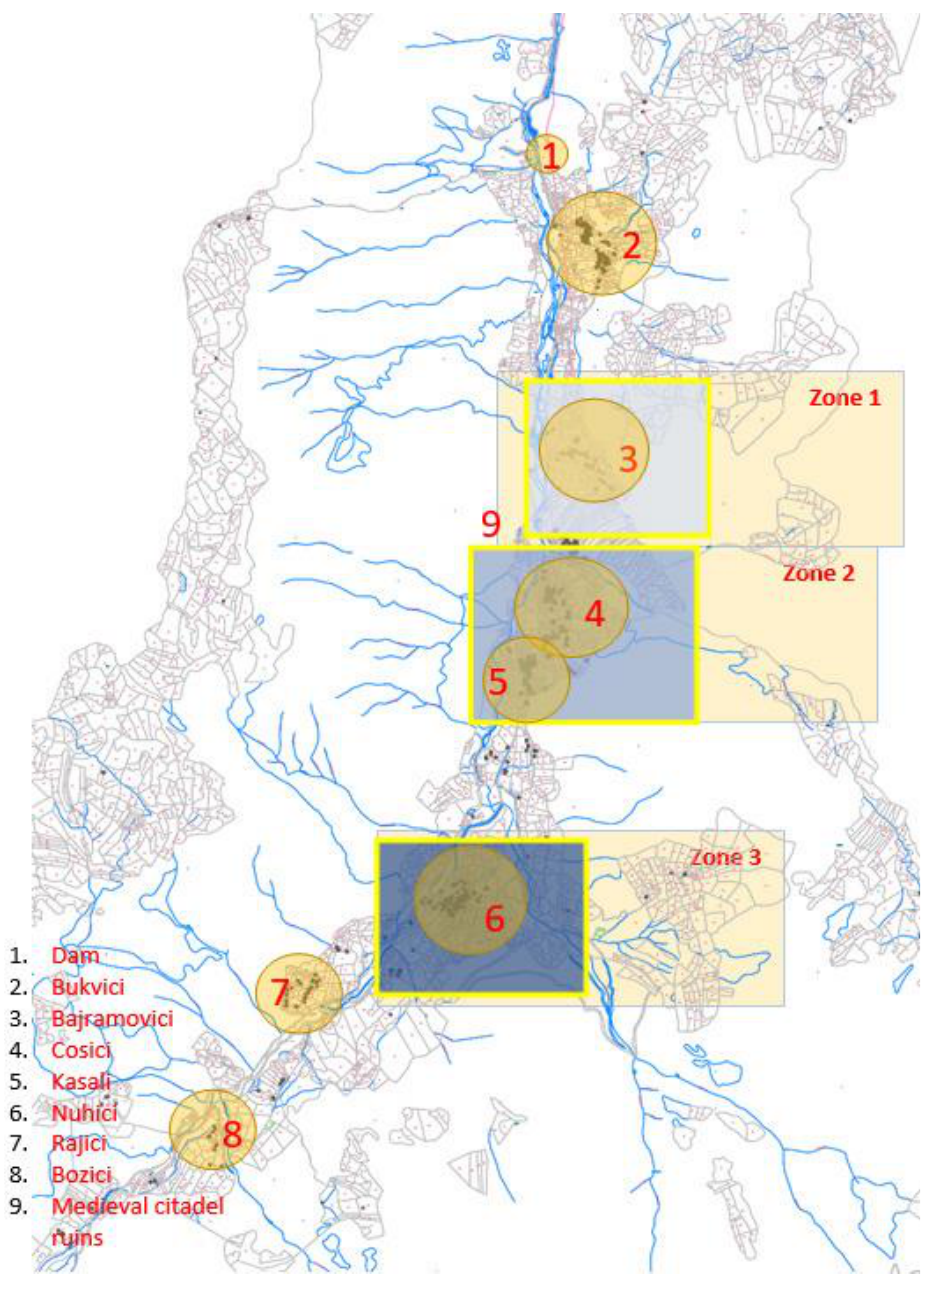
Figure 7. Village Idbar reuse zones. (Source: